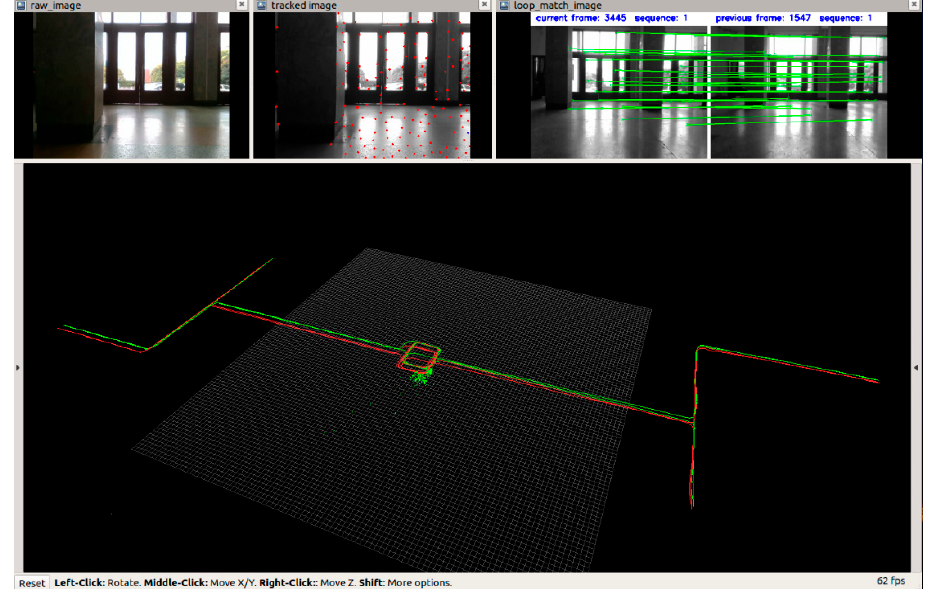
Figure 5. RViz interface at the end of test data playback.